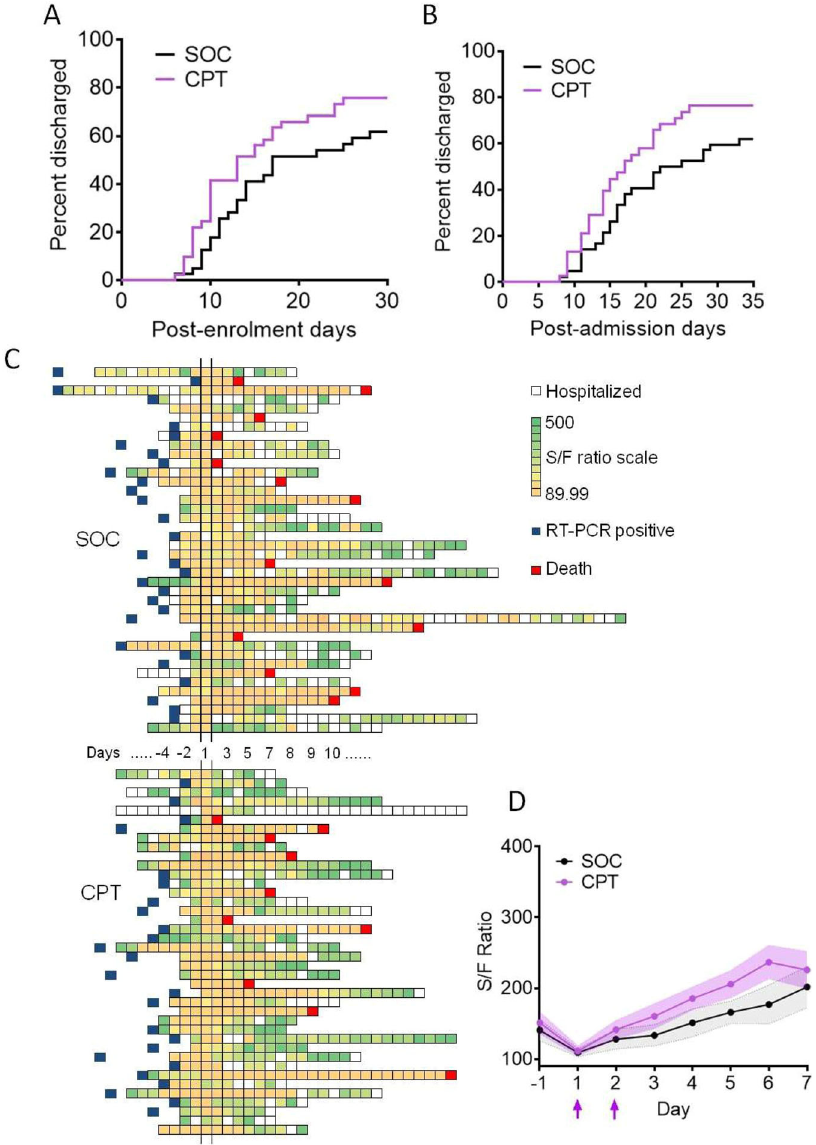
plotted in an ascending Kaplan – Meier curve, for all age groups. Deaths and non-remission at day 35 post-admission were censored. B Hospital stay duration of the patients from both arms since the day of enrolment are plotted in an ascending Kaplan – Meier curve, for all age groups. Deaths and non- remission at day 30 post-enrolment were censored. C Representative plot of SpO 2 /FiO 2 kinetics (shaded as per the colour scale depicted) of individual patients during hospitalization. The blue box denotes day of diagnosis through RT-PCR for SARS-CoV-2 and the red boxes denote time of death. D The ratio between saturation of O2 in blood (SpO 2 ) and fraction of O2 received (FiO2), or S/F ratio is plotted for patients in SOC (black line) and CPT (purple was transfused. 95% con fi dence interval is shown for each